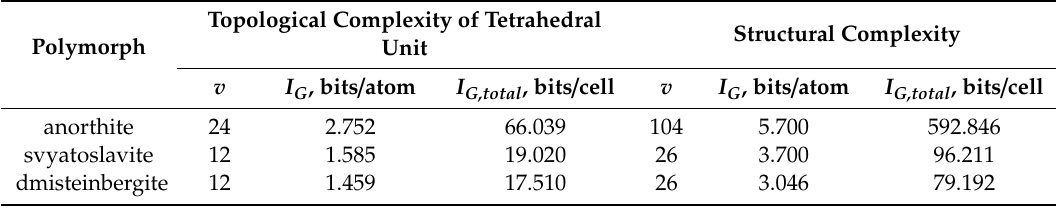
Table 6. Information-based structural complexities of CaAl 2 Si 2 O 8 polymorphs and topological complexities of their tetrahedral units.